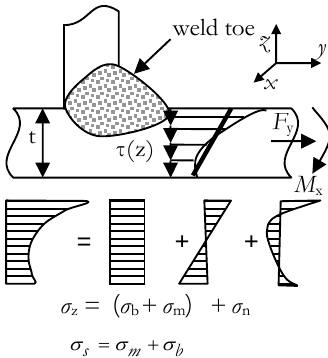
Figure 1: Stress distribution at the weld